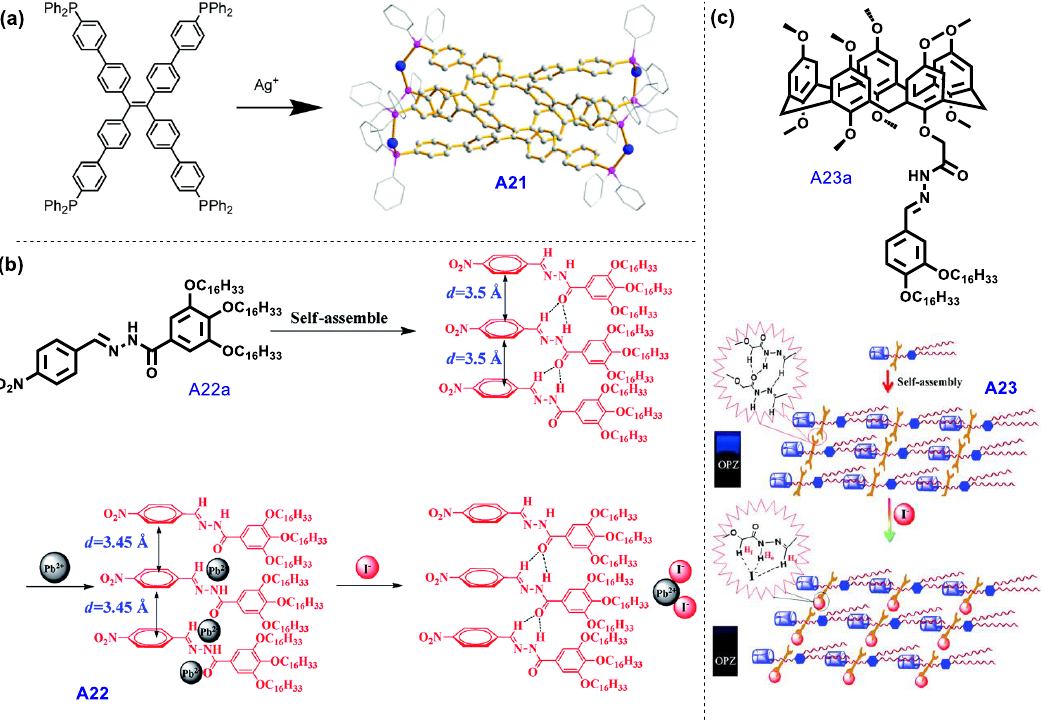
Scheme 4. Chemical structures of AIE-based iodide chemosensors A21 ( a ) , A22 ( b ) and A23 ( c ), with selected sensing mechanisms (for A22 and A23 ) shown in ( b ) and ( c ), respectively. Reproduced with